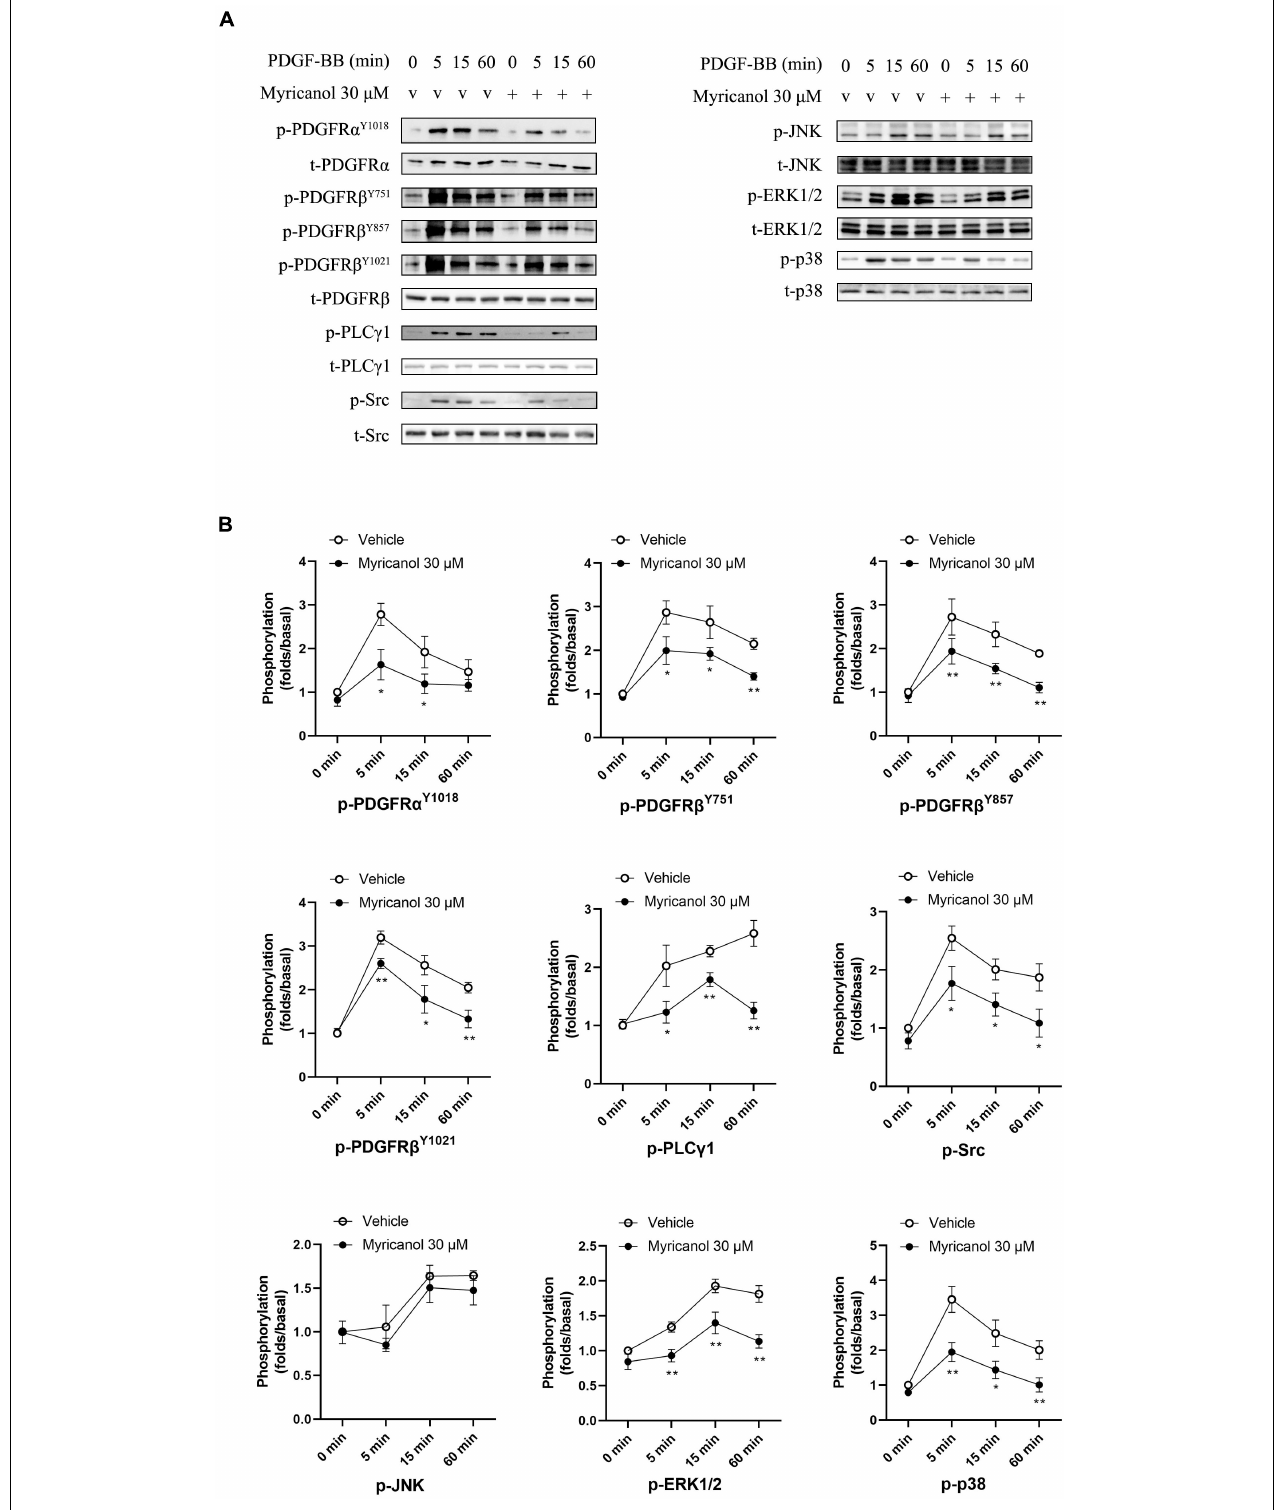
FIGURE 3 | Effect of myricanol on the phosphorylation of PDGFR β , PLC γ 1, Src and downstream MAPKs. (A) The protein level of phosphorylated PDGFR α , PDGFR β , PLC γ 1, Src, JNK, ERK1/2 and p38 were determined by Western blot analysis. (B) Quantification of the Western blot analysis. Data are represented as mean ± SEM ( n = 3). * P < 0.05, ** P < 0.01 vs. the Vehicle + PDGF-BB group.